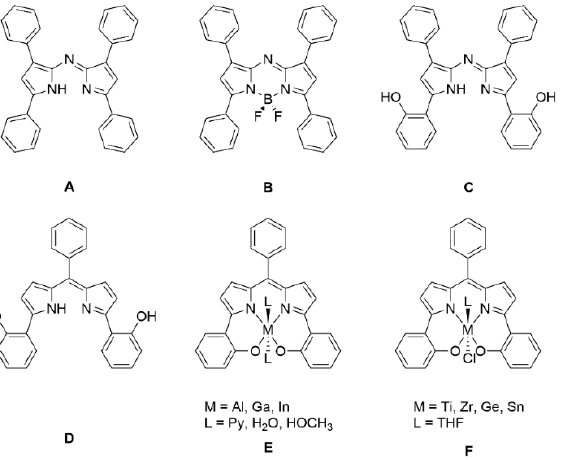
Figure 1. Aza-DIPY ( A ), aza-BODIPY ( B ), bis(phenolate) aza-DIPY ( C ), bis(phenolate) DIPY ( D ), bis(phenolate) DIPY main group chelates ( E ) and bis(phenolate) transition metal chelates ( F ).